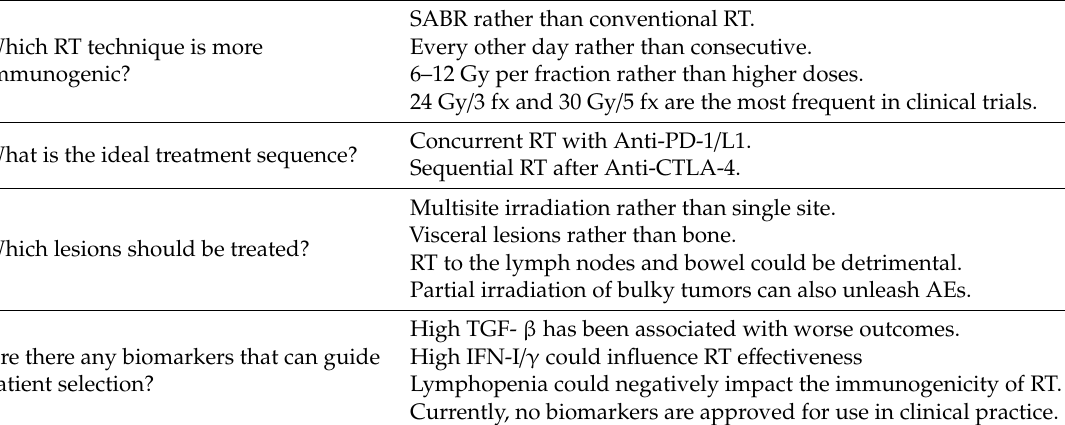
Table 6. Key questions for a treatment with